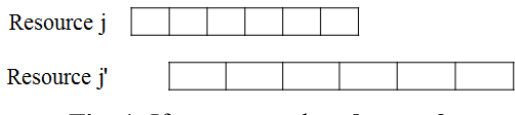
, then (cid:1835) ≤ (cid:1872) (cid:3036)(cid:3037) (cid:3036)(cid:3037) (cid:4594)